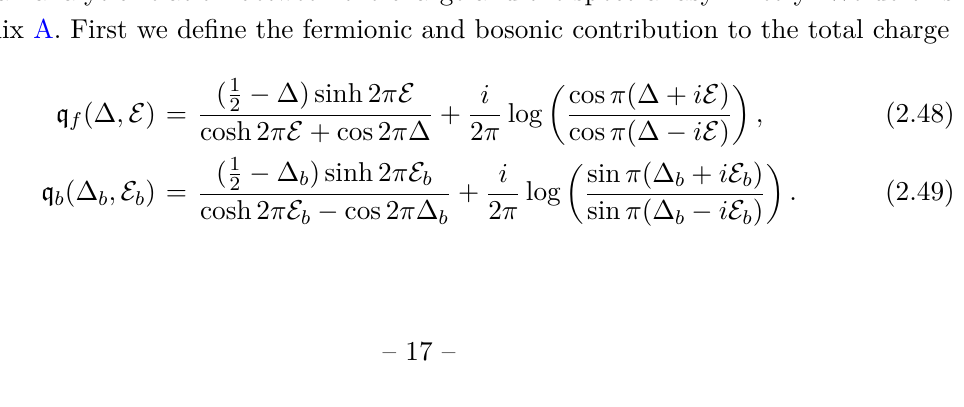
and G c and we observe good agreement up when ψψ b ψ b ψ